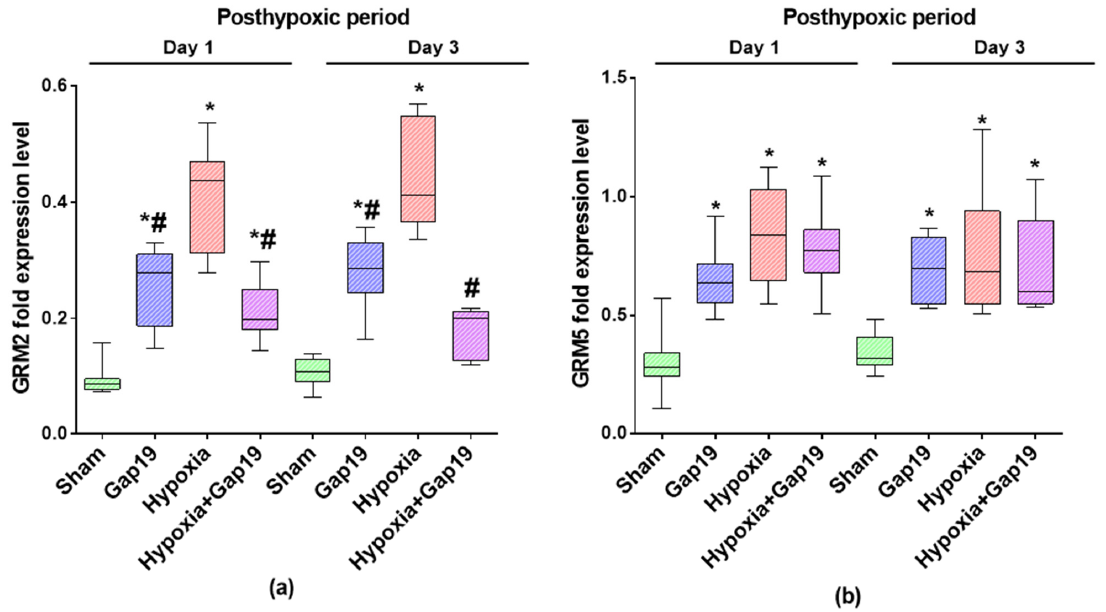
Figure 2. Assessment of the levels of mRNA expression of metabotropic glutamate receptors mGluR2 and mGluR5 in primary cerebral cortex cells in the post-hypoxic period. Data were normalized relative to values of reference gene Oaz1. ( a ) Day 1 after hypoxia exposure; ( b ) Day 3 after hypoxia exposure. * versus “Sham”, # versus “Hypoxia”; p < 0.05, the Mann–Whitney test.